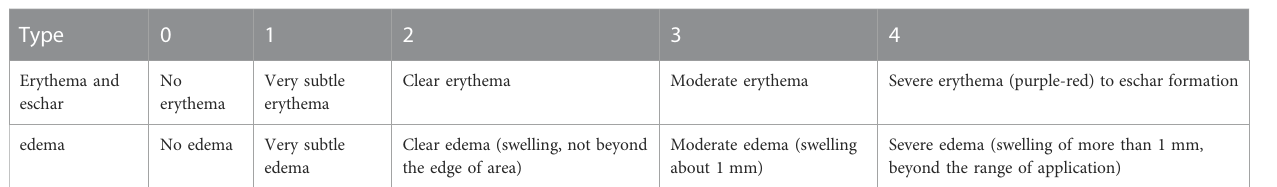
TABLE 2 Skin and intradermal stimulation response scoring system.